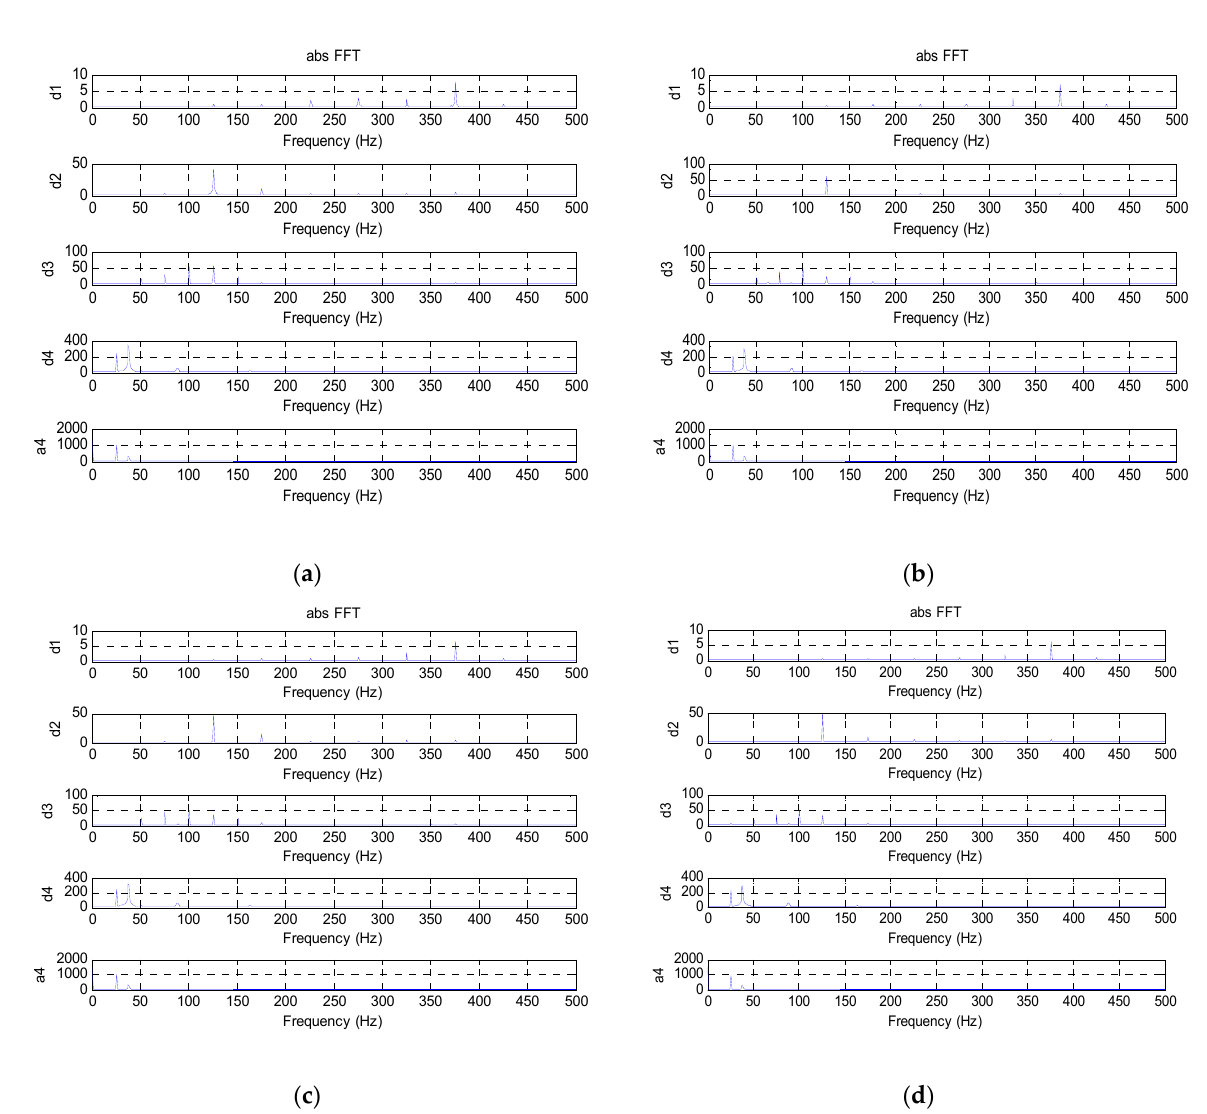
Figure 9. Plotting current waveform in frequency domain used wavelet decomposition fourth level. ( a ) misalignment 10% (0.05 mm); ( b ) misalignment 20% (0.1); ( c ) misalignment 30% (0.15 mm); ( d ) misalignment 40% (0.2 mm).